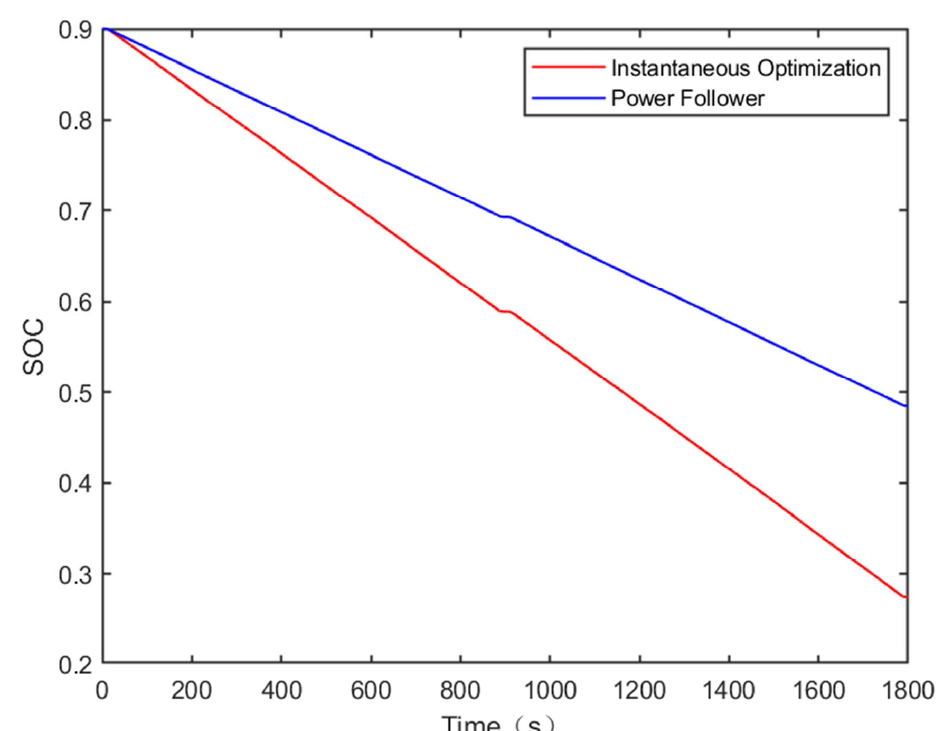
Figure 13. SOC state value changes.